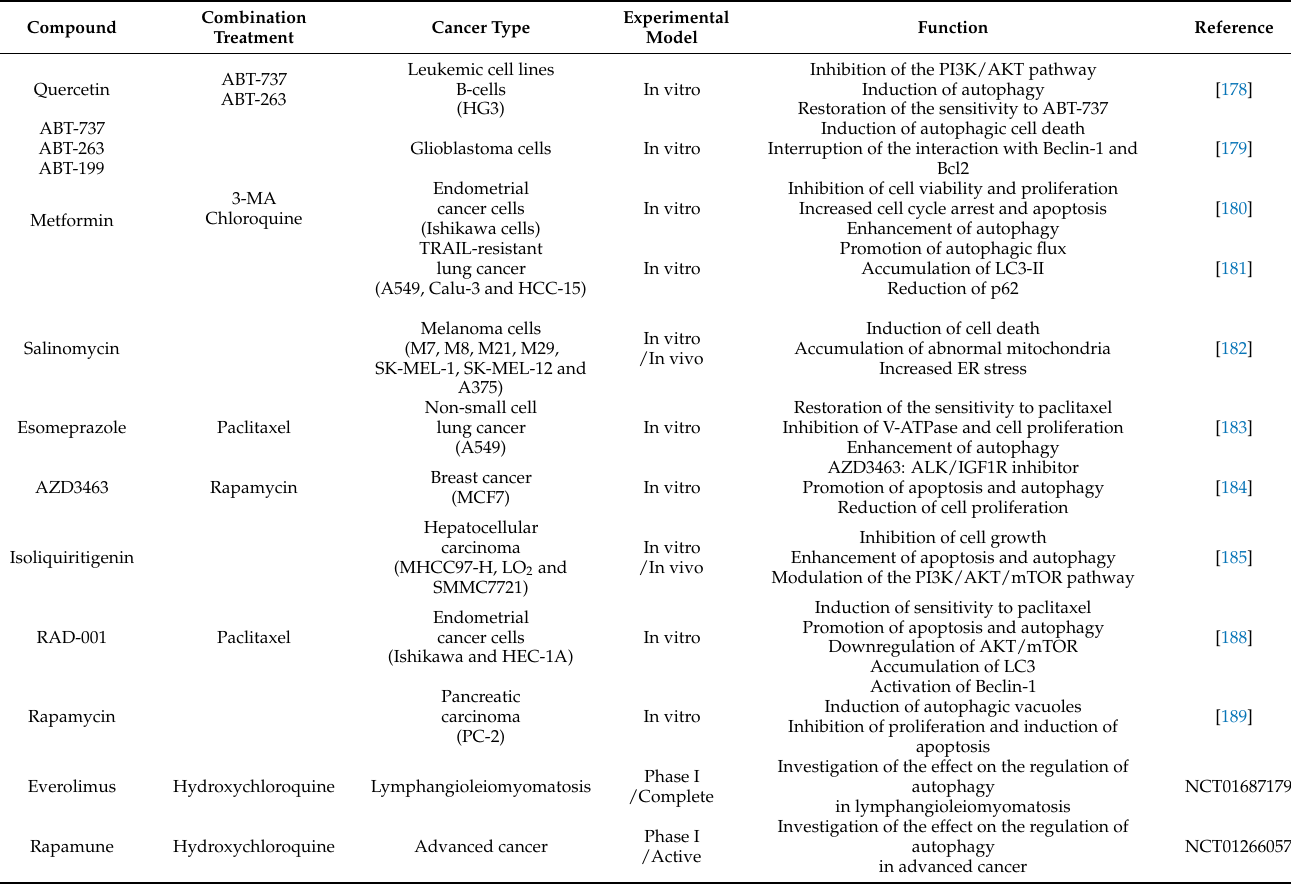
Table 2. The role of autophagy promoters in cancer